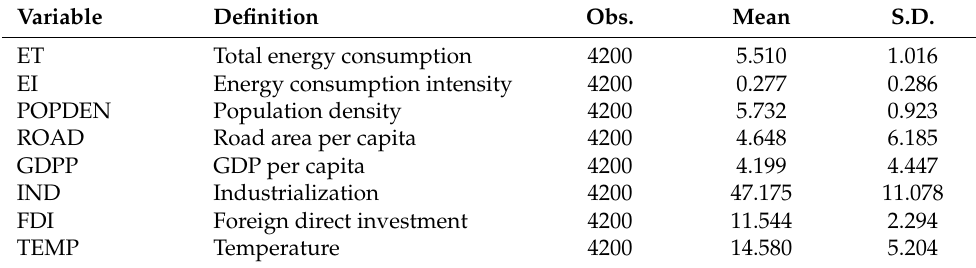
Table 1. Descriptive